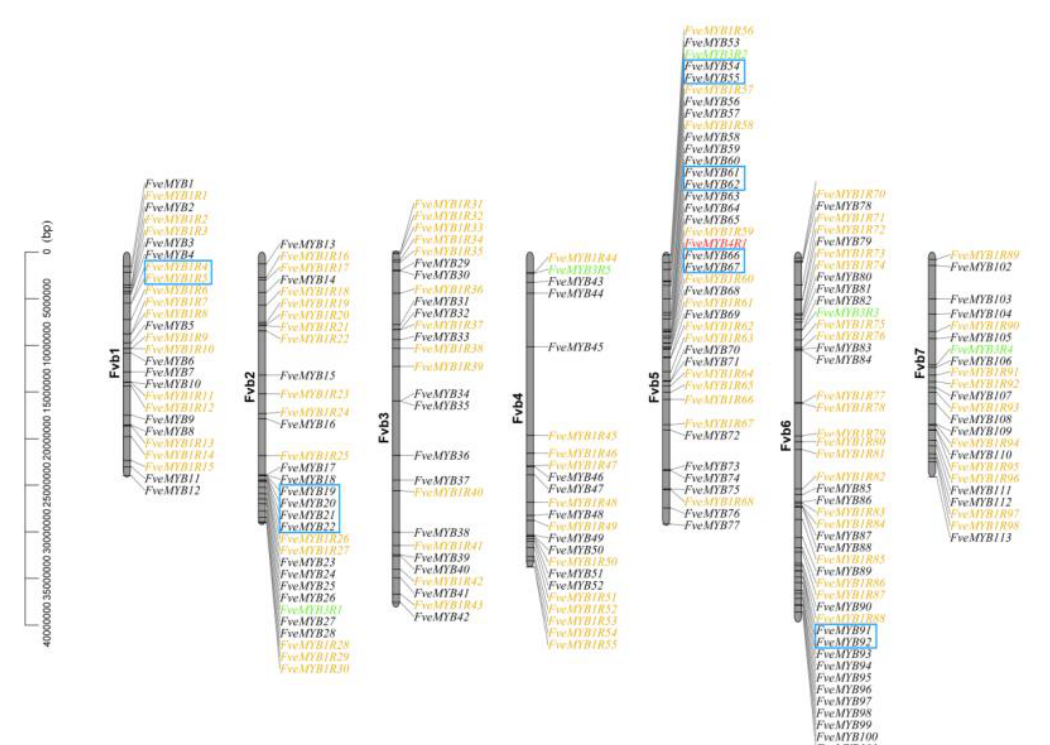
Figure 5. The physical location and gene duplication of MYB genes in woodland strawberry. The 217 FveMYB genes were located on seven chromosomes (Fvb1–Fvb7). Genes in black on the right side of each chromosome indicate the 2R-MYB genes, whereas genes in yellow represent the 1R-MYB genes. Genes in green represent the 3R-MYB genes, and gene in red represents the 4R-MYB gene. Six FveMYB gene clusters were in blue boxes. The scale bar on the left represents the genetic length of the chromosomes.